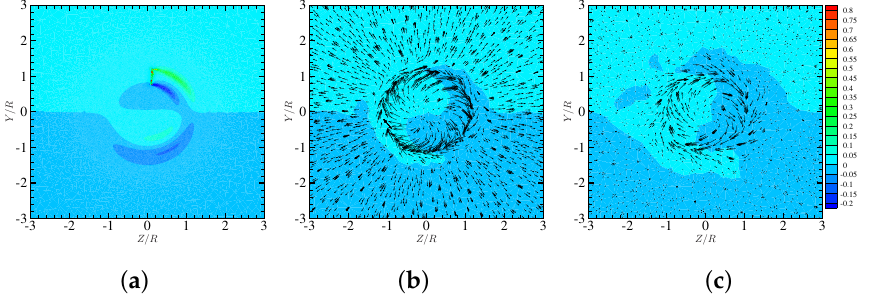
Figure 7. The distribution of the instantaneous, dimensionless vertical (or Y -component) flow ve- locity, V / U ∞ , in the YZ -plane at different axial distances from the plane of rotation: ( a ) X / R = 0, ( b ) X / R = 2, and ( c ) X / R = 4. The arrows represent the in-plane flow velocity vector at differ- ent points.